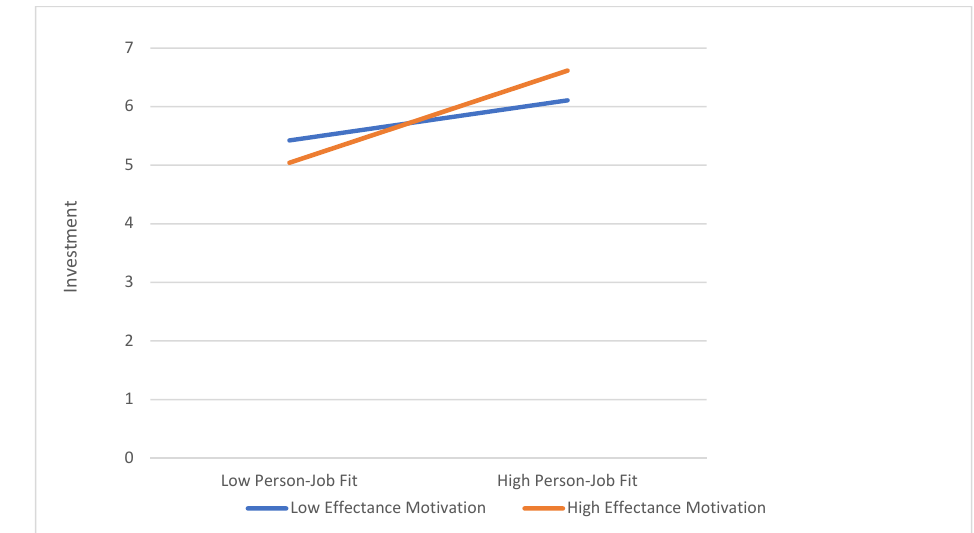
Figure 2. Illustration of interactions of person-job fit, and self-identity needs and effectance motiva- tion, on perceptions of route variables. Table 2. Results from tests of direct and interactive hypothesized relationships between person-job fit, routes to psychological ownership, and self-identity and effectance